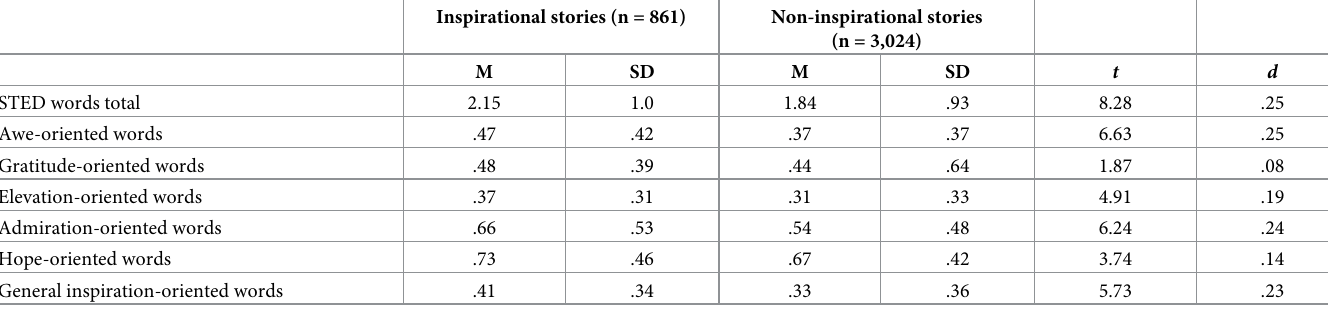
Table 3. Summary of self-transcendent word use in socially shared New York Times